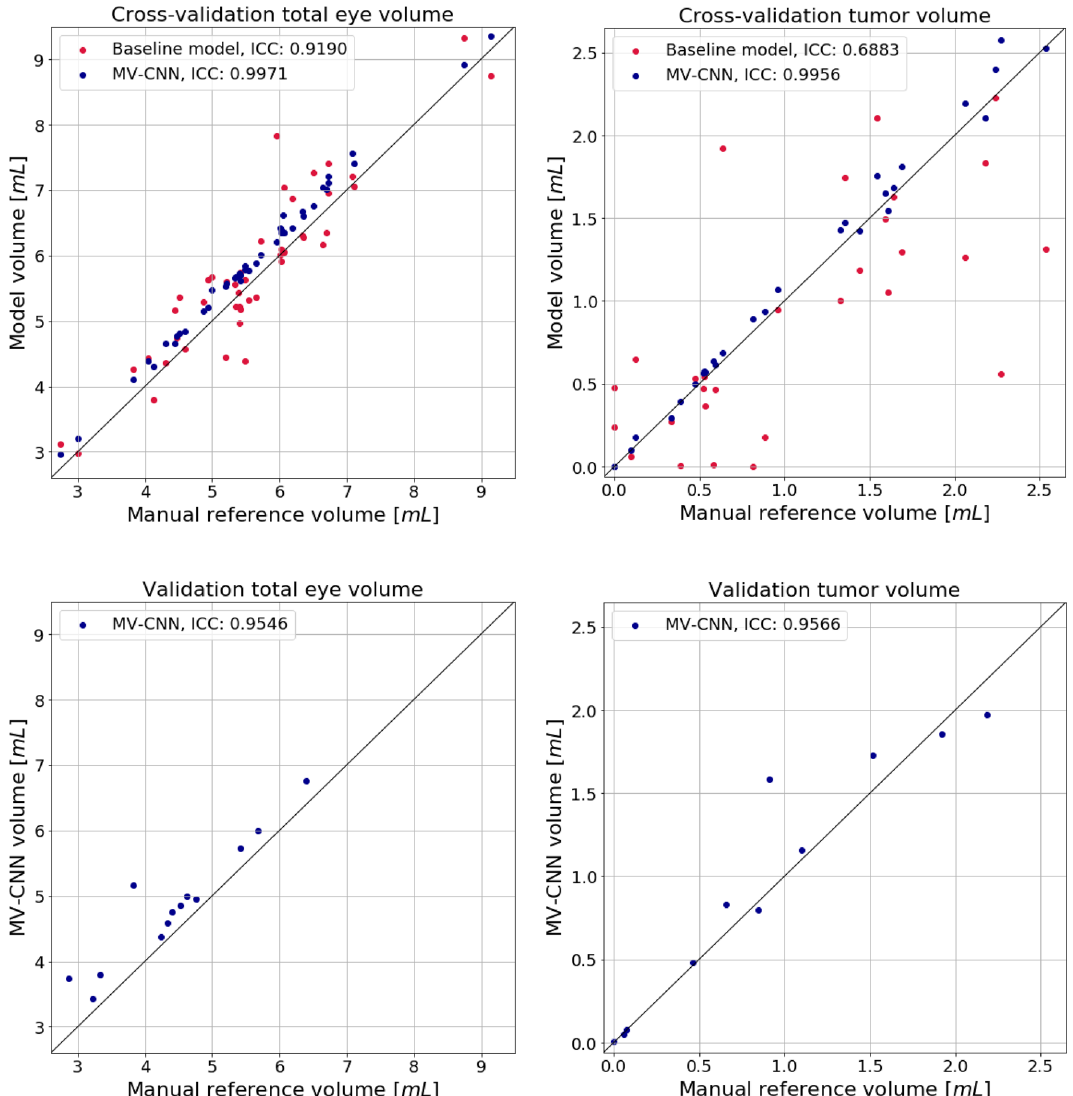
Figure 3. Eye and tumor volumes in the cross-validation (top) and validation (bottom) datasets. The black diagonal lines indicate identity. ICC intra-class correlation (single measures, absolute agreement); MV multi- view; CNN convolutional neural network. Figure was generated using Python (version 3.6.9; https:// www. python. org) including the package Matplotlib (version 3.3.1; http:// matpl otlib. org) 31